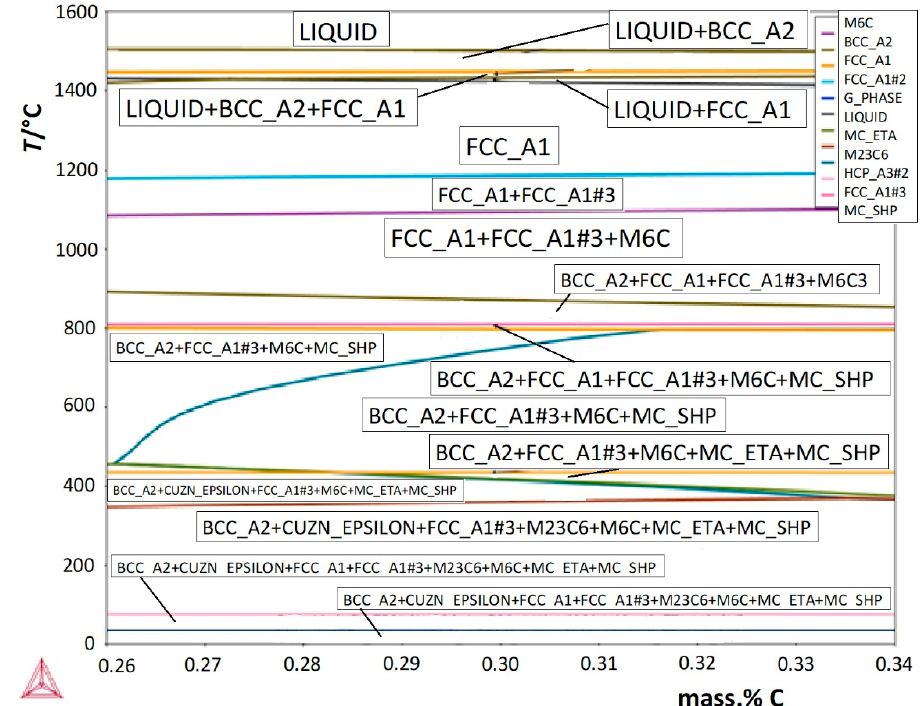
Figure 2. Isopleth phase diagram of HTCS-130 hot work tool steel.